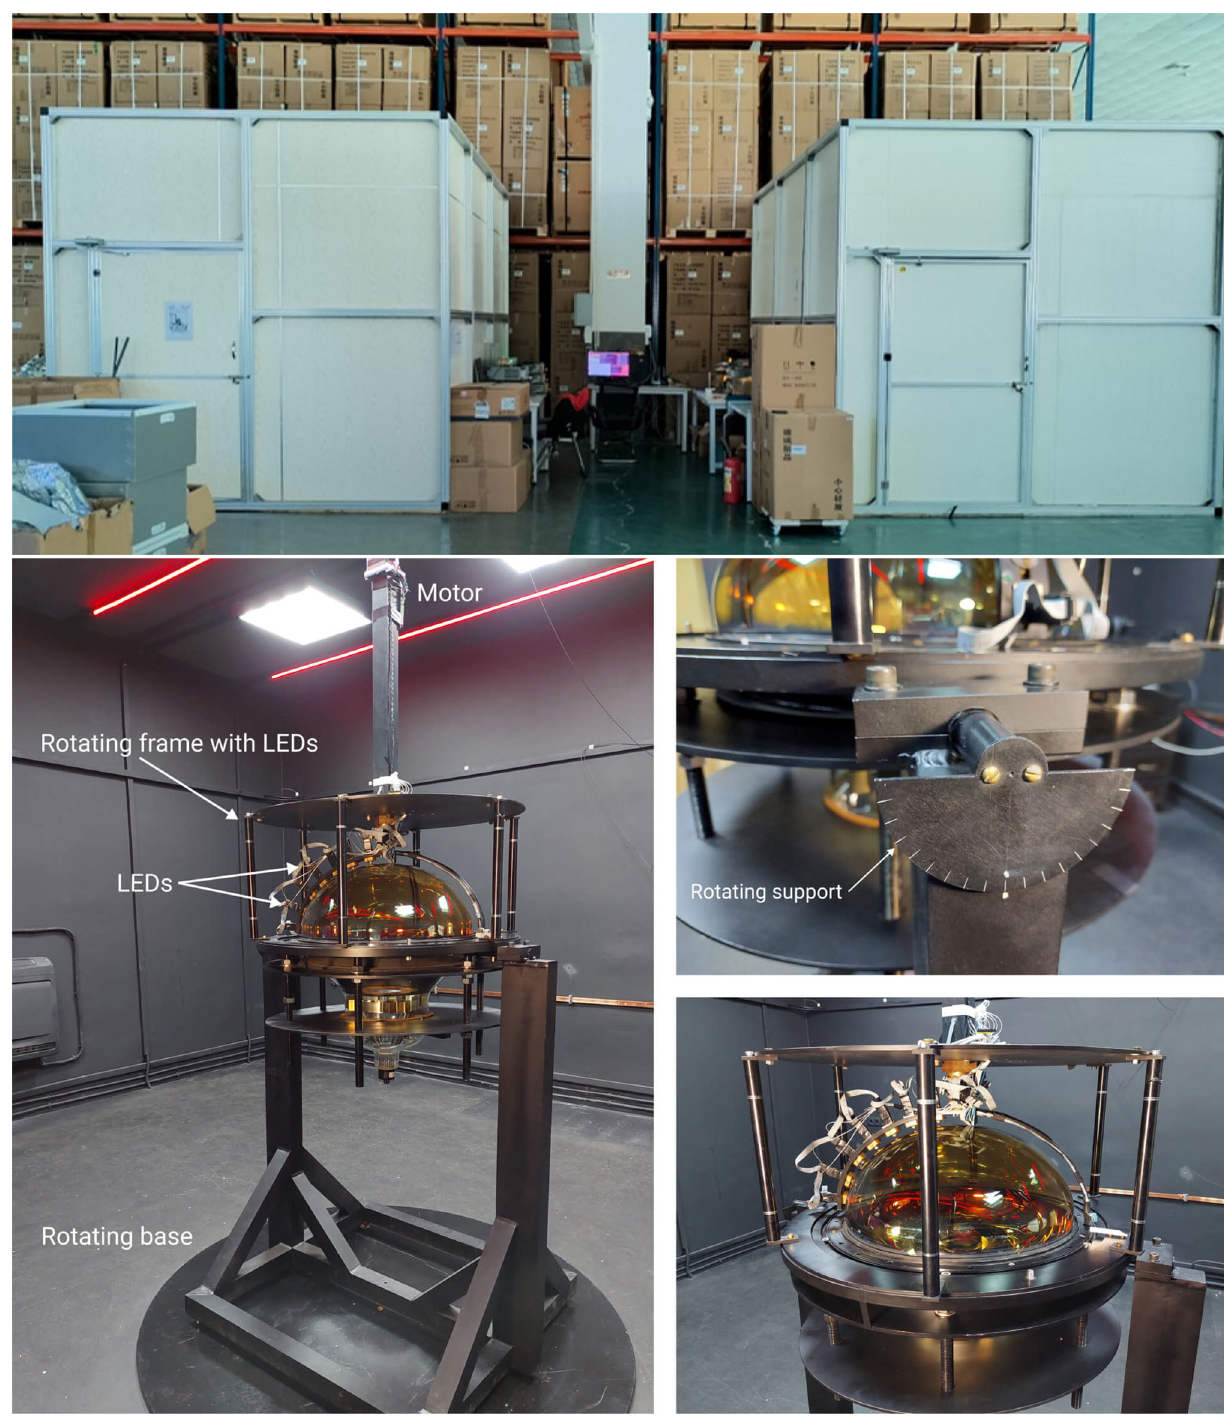
Fig. 4 Pictures of the scanning station system. Top: the darkrooms used for the two scanning stations; bottom: mechanical setup and rotating support of a single scanning station